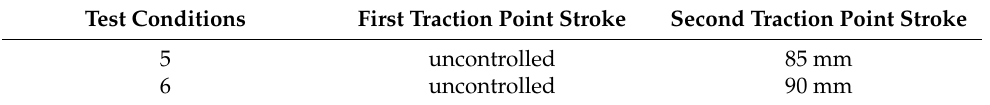
Table 3. Numerical test conditions.